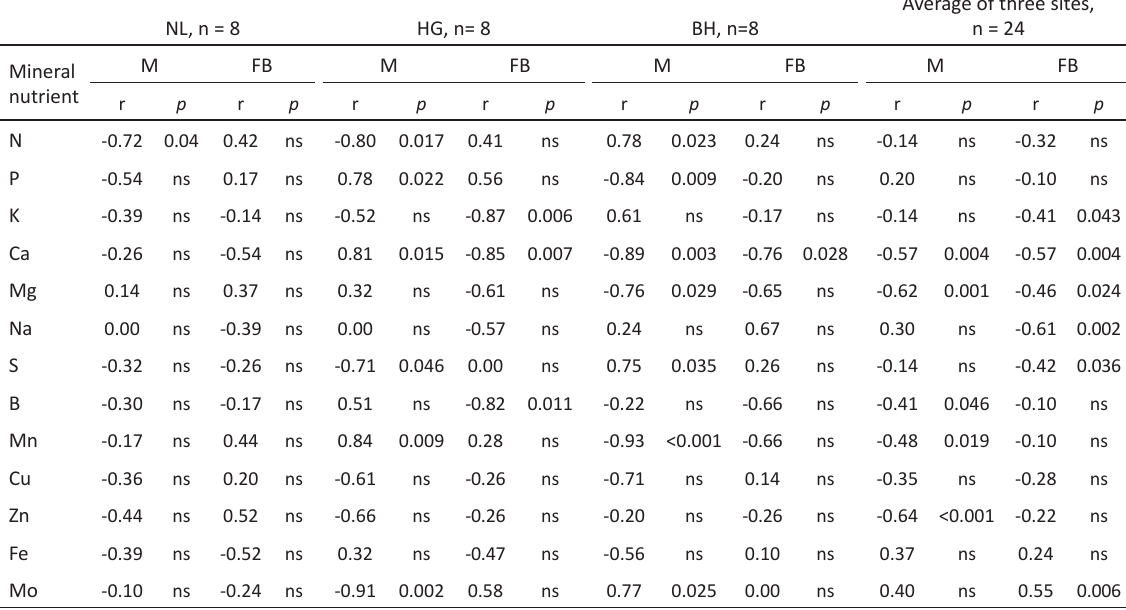
Average of three sites, n = 24